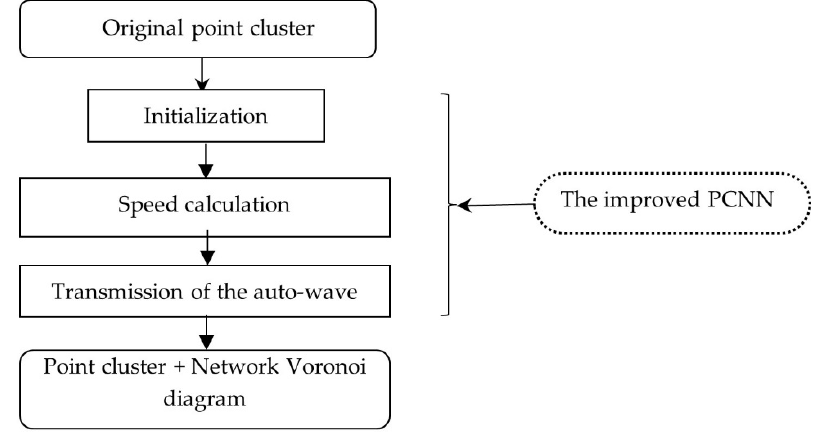
Figure 4. Flowchart of the algorithm.